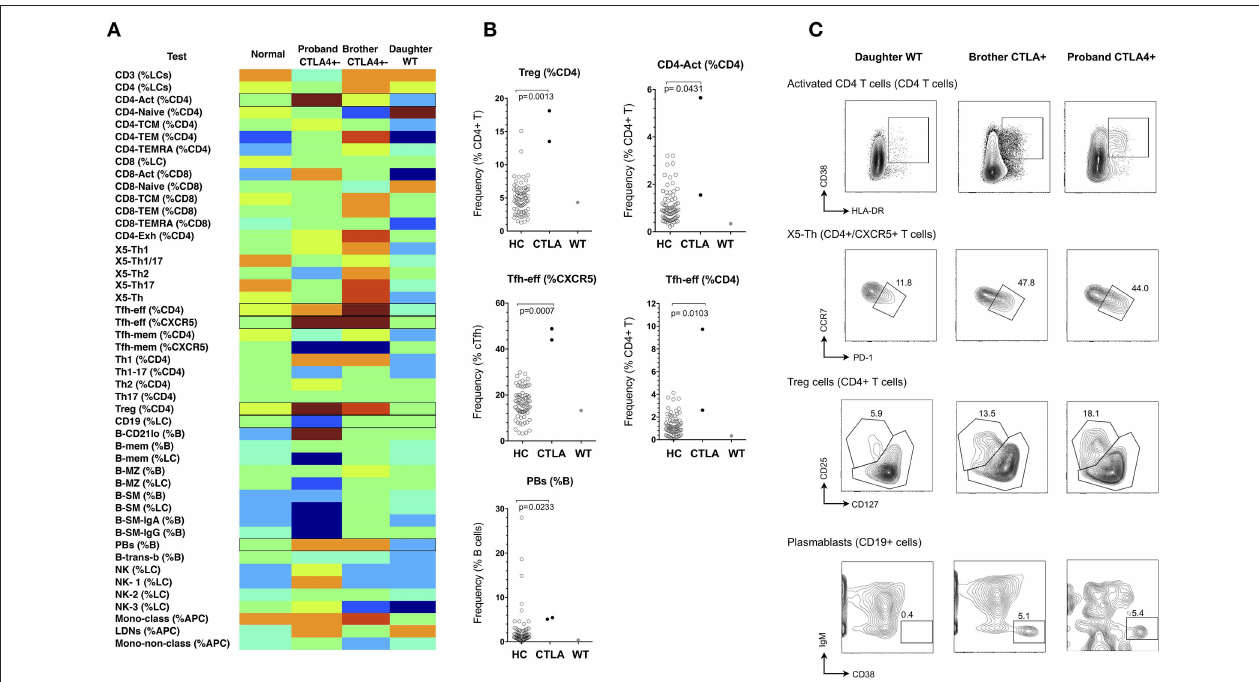
FIGURE 5 | Analysis of cellular parameters in a CTLA4 haploinsufficient kindred. (A) Heat mapping with discontinuous shading showing changes in cell populations for the CTLA4 haploinsufficient proband with CVID, in comparison with the clinically normal brother with the CTLA4 mutation, the unaffected proband’s adult daughter without CTLA4 mutation and the internal control. Boxes highlight parameters for which cellular changes differ between the two CTLA4 mutants, the unaffected subjects, and between the CTLA4 mutants with or without clinical expression. (B) Scatter plots showing raw values for populations identified in (A) , along with representative FCM contour plots of these critical parameters (C) . Raw and centile data is presented in Supplementary Table 3